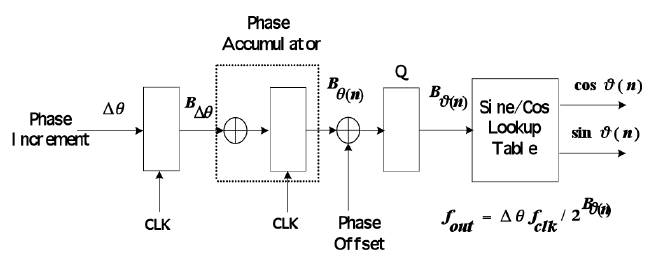
Figure 2. Block diagram of the DDS in the transmitting path.